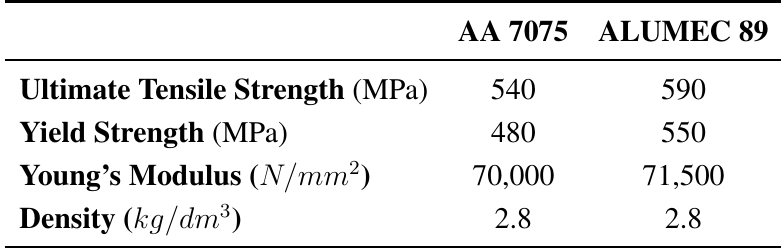
Table 6. Mechanical properties of Aluminium